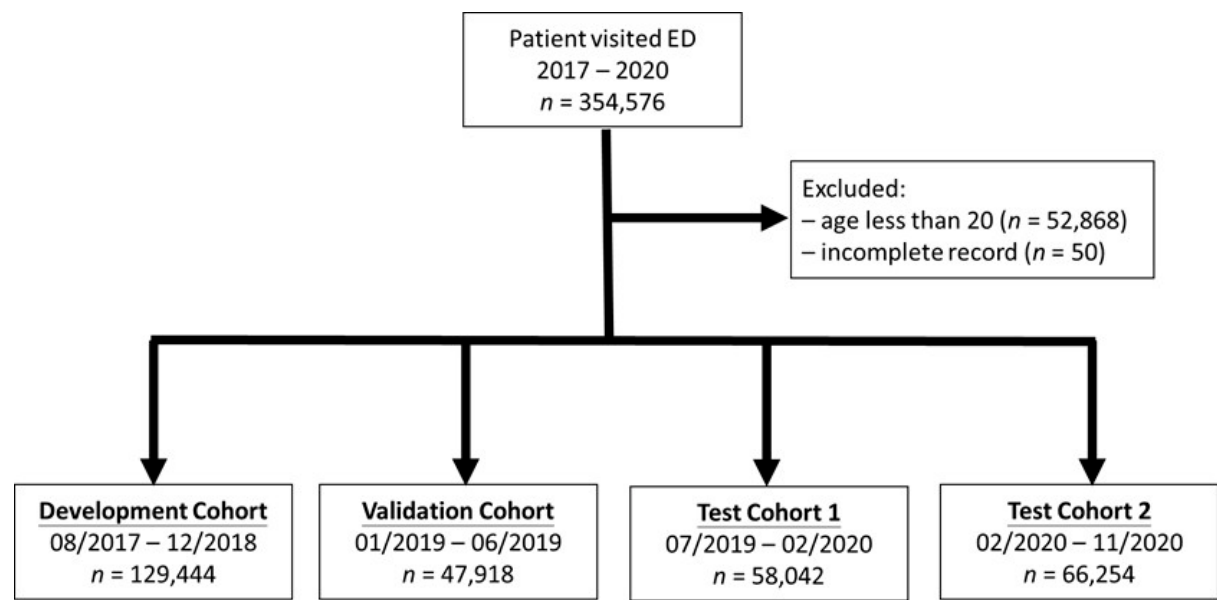
Figure 1. Flowchart diagram of the study cohort generation.